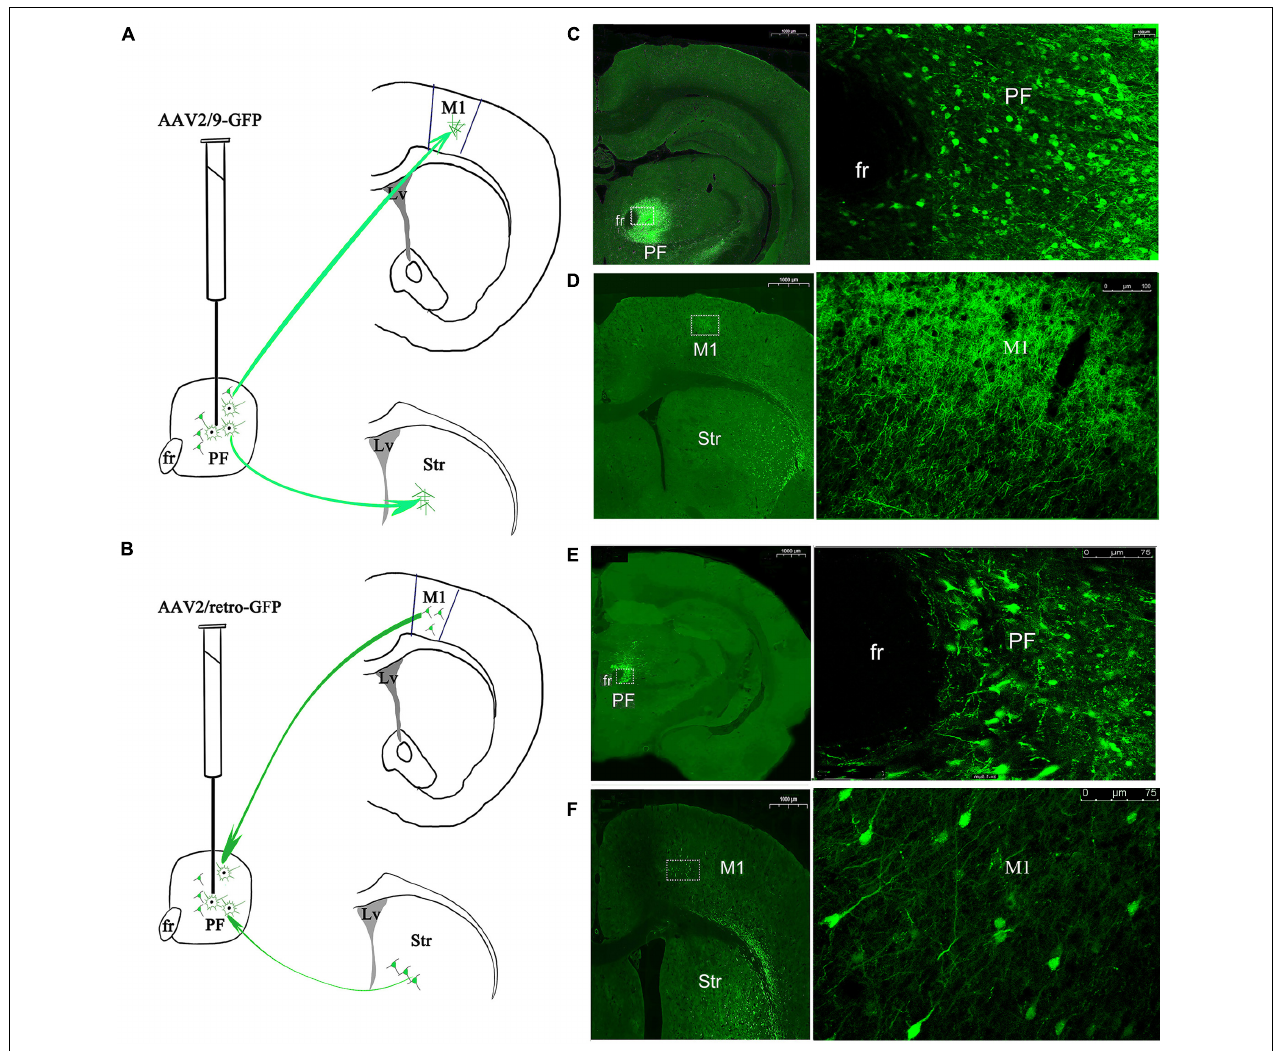
FIGURE 11 | Immunofluorescent adenoviral vector tracers were stereotaxically injected into the rat PF to visualize afferent and efferent projections. Schematic of the procedures used to inject the (A) anterograde tracer AAV2/9-GFP and (B) retrograde viral vector tracer AAV2/retro-GFP. Expression of the anterograde tracer in PF neurons. The left lateral images are magnified views of the rectangles in the medial images, with cell bodies and dendritic neuropil of GFP-immunopositive neurons shown (C) and projecting to M1. The left lateral images are magnified views of the rectangles in the medial images, with only dendritic neuropil of GFP-immunopositive neurons shown (D) . Expression of the retrograde tracer in PF neurons. The left lateral images are magnified views of the rectangles in the medial images, with cell bodies and dendritic neuropil of GFP-immunopositive neurons shown (E) . Anterograde transport from the PF projects to axon terminal fields in the M1 and striatum. The left lateral images are magnified views of the rectangles in the medial images, with cell bodies and dendritic neuropil of GFP-immunopositive neurons detected in the M1 (F) . PF, parafascicular nucleus of the thalamus; fr, fasciculus retroflexus; M1, primary motor cortex; Str,